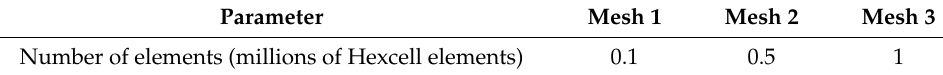
Table 4. Approximate number of tested meshes elements for mesh independence study.